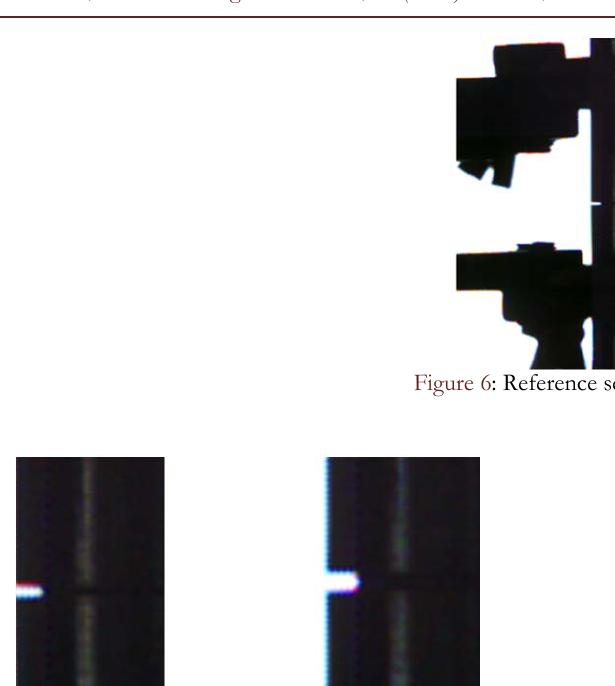
R ESULTS AND DISCUSSION